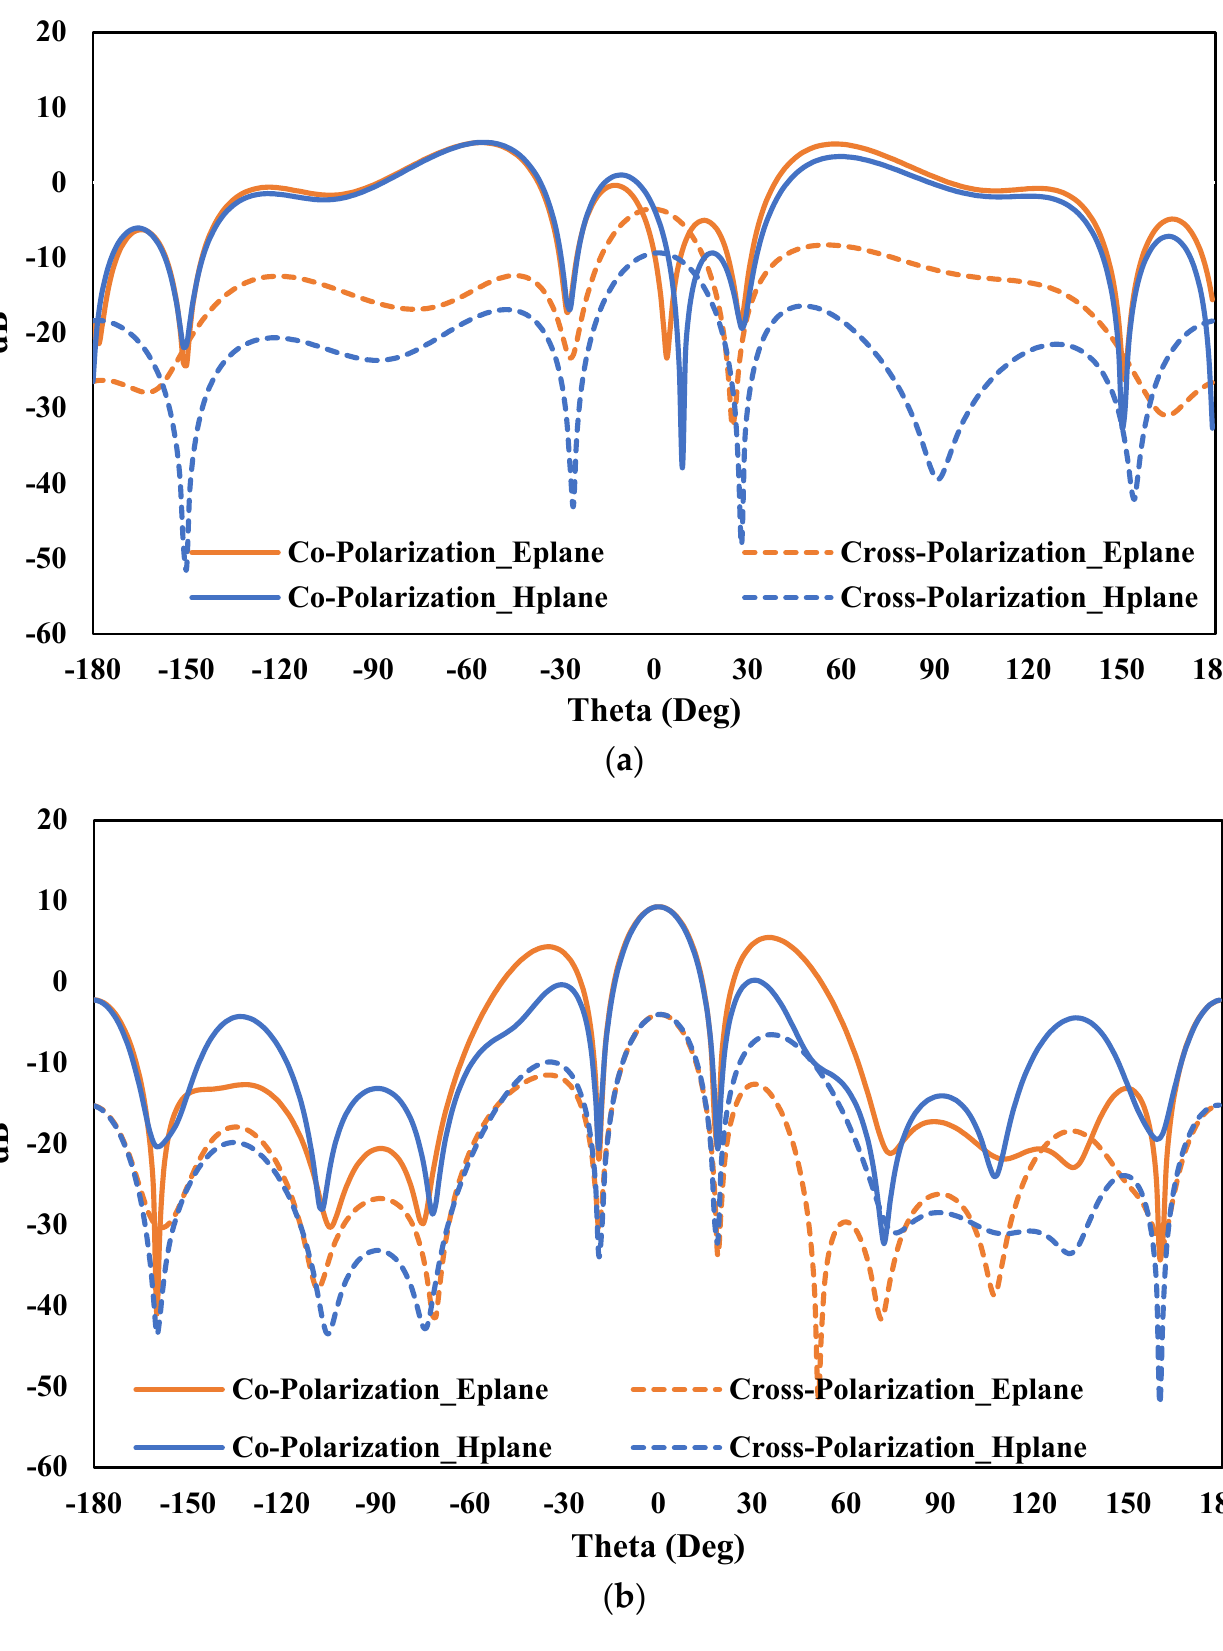
Figure 12. Shows the co − and cross − polarization analysis of the four − element MSFAA for E − and H − plane at ( a ) 4.17 GHz and ( b ) 5.97 GHz, respectively.